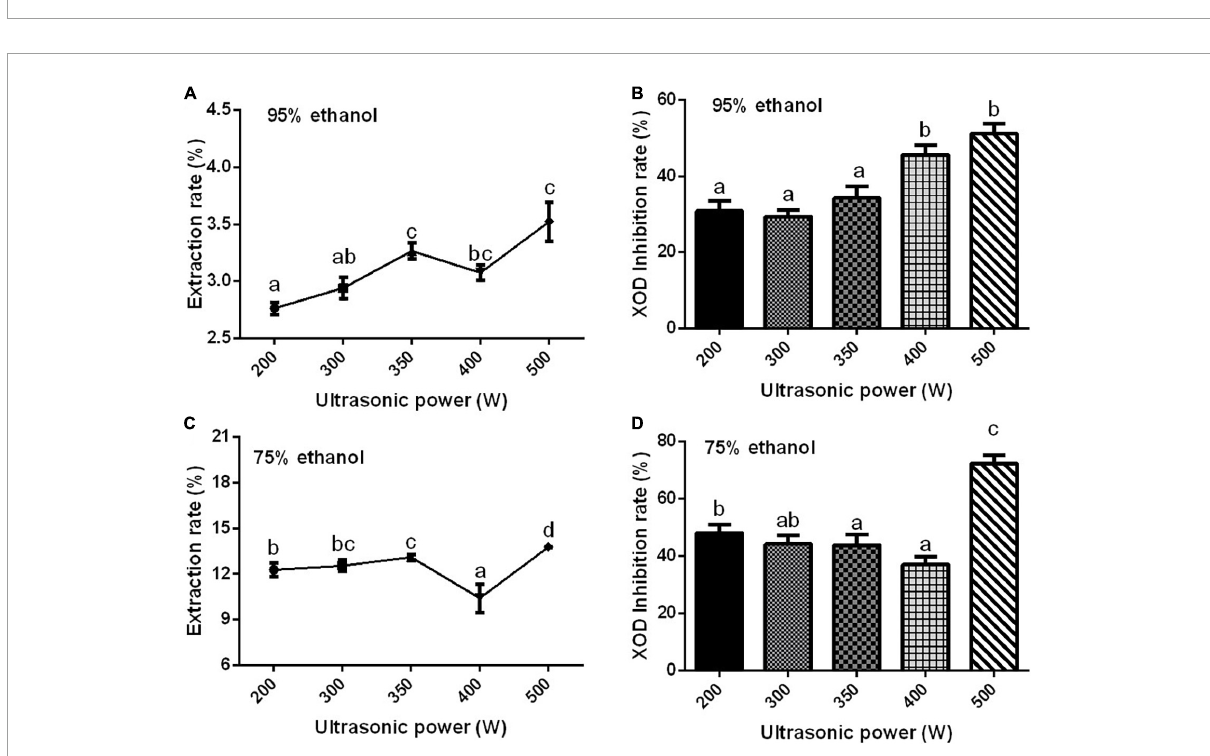
FIGURE3 The effect of ethanol concentration. (A,C) The effect of ultrasonic power on the extraction rate of ethanolic extract of Gym [ (A) 95% and (C) 75%]. (B,D) The effect of ultrasonic power on XOD inhibition rate [ (B) 95% and (D) 75%]. The different letters indicate significant difference ( P <